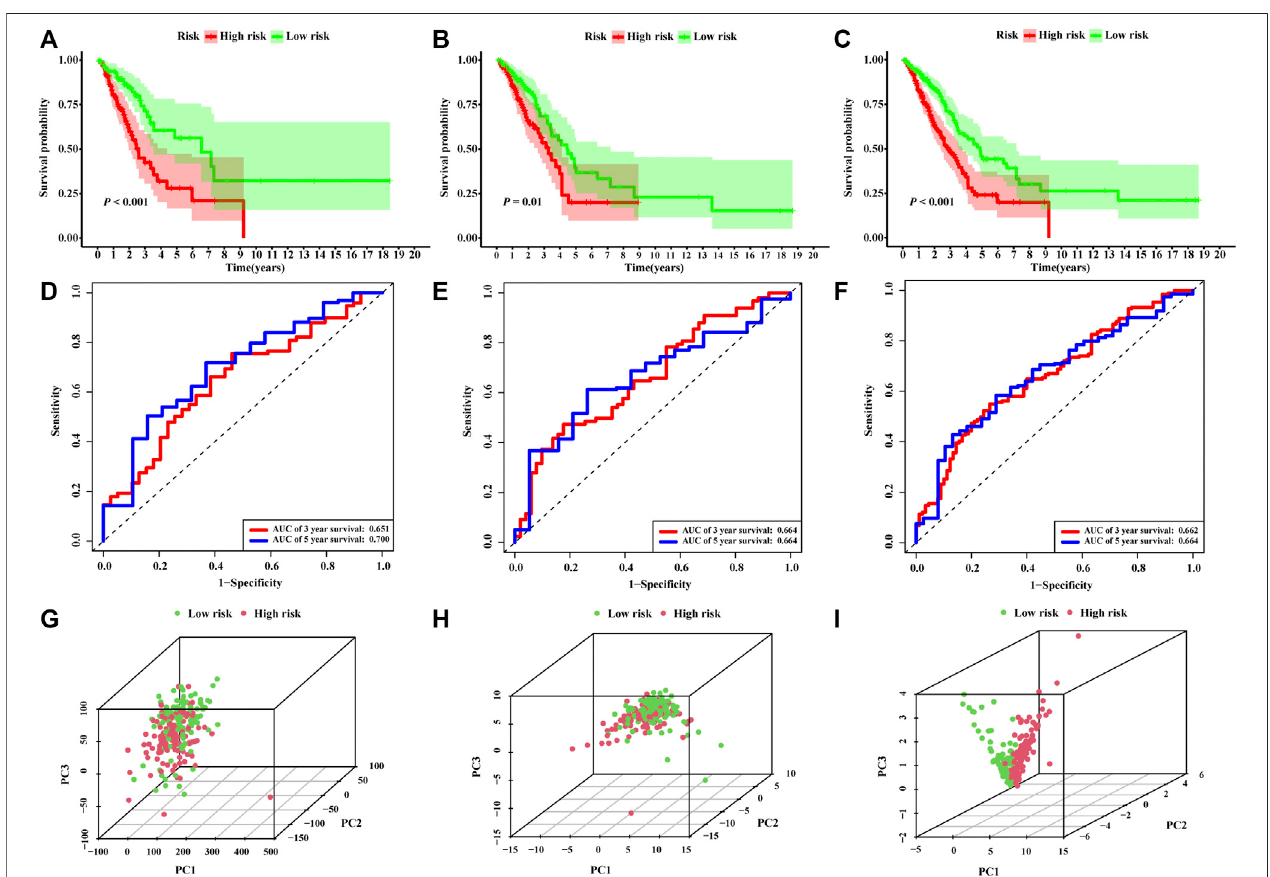
FIGURE 4 | Assessments of the necroptosis-related lncRNA signature (NRLsig). (A – C) Kaplan – Meier survival analysis curves of the high-risk group and low-risk group strati fi ed by NRLsig in the training, validation, and entire TCGA-LUAD set, respectively. (D – F) Time-dependent ROC curves at 3- and 5-year follow-up in the training,validationandentireTCGA-LUADset,respectively.Principalcomponentanalysis(PCA)ofthelow-riskgroupandhigh-riskgroupstrati fi edbythewhole-genome (G) , necroptosis-related genes (H) , and the NRLsig (I)